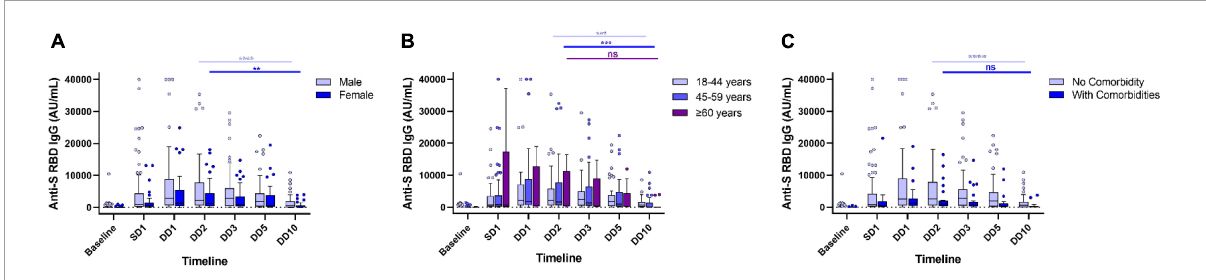
FIGURE2 Waning of humoral immune response in Covishield recipients without any breakthrough infection. Levels of anti-spike RBD IgG antibody stratified by gender (A) , age (B) , and comorbidities (C) in Covishield recipients at different timepoints during a year-long follow-up. ns, non-significant; ** p < 0.01; *** p < 0.001; **** p < 0.0001. Tukey method was used to plot whiskers. SD1, 1 month after single dose. DD1, 1 month; DD2, 2 months; DD3, 3 months; DD5, 5 months; DD10, 10 months after double dose.